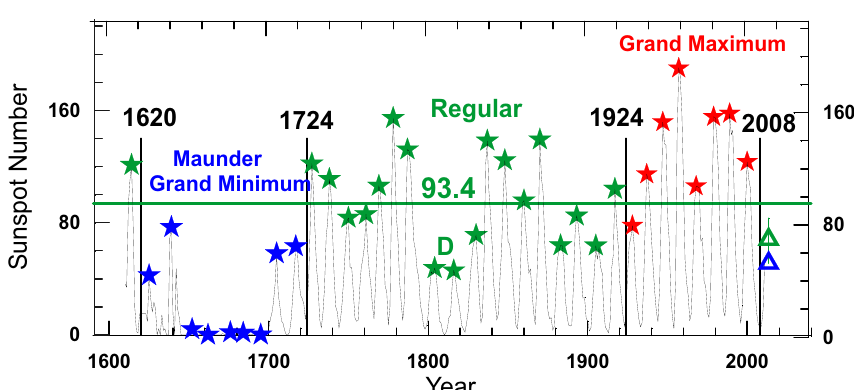
Fig. 4. The sunspot cycles since 1610. The diagram shows the sunspot numbers plotted against time. The stars are the maximum values of the sunspot (Schwabe) cycles. The strong variations are apparent. The three Grand Episodes are marked by their different colours. They are separated by vertical black lines – cf. Figure 5, later this section. The open triangles are our predictions, based on the two types of aa data used, viz. the standard data (green; De Jager & Duhau 2009) and the Lockwood data (blue; Duhau & De Jager 2010).The vertical green line through the green triangle is the estimated error. The horizontal line at sunspot number R (cid:2) 94 marks the level of the Transition Point, cf. its definition later in this section.